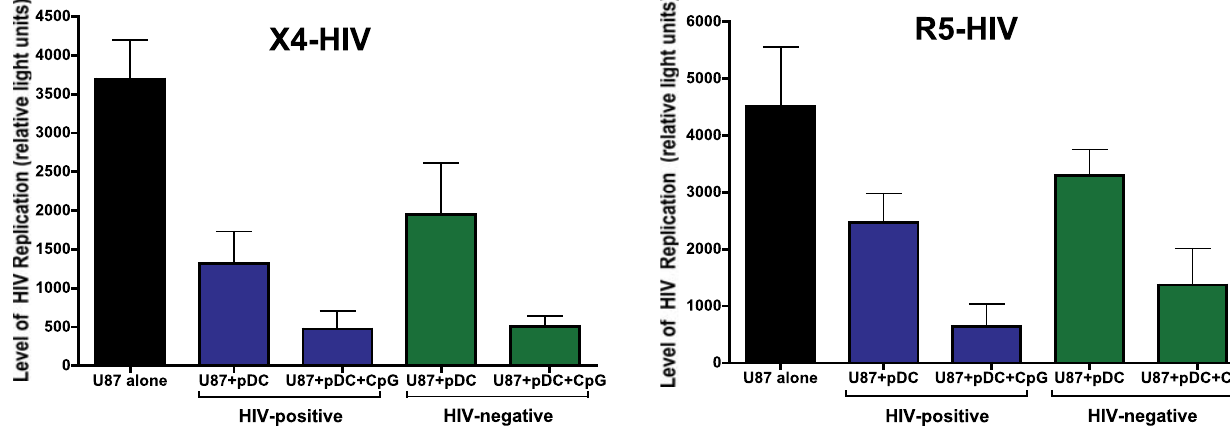
Figure 1. pDC-mediated suppression of HIV infection invitro. U87 cell lines expressing CD4 and either CXCR4 or CCR5 were infected with pseudotyped luciferase HIV SF (X4) or HIV JRFL (R5), respectively. Purified pDCs (10 4 ) from HIV-infected (n=11) or uninfected (n=4) individuals were cocultured with 2 6 10 4 U87 cells, with or without 1 m g/ml CpG ODN 2216 in triplicate wells. After two days of incubation, cells were lysed and luciferase activity following addition of substrates was quantified by a luminometer. Error bars indicate the standard error of the